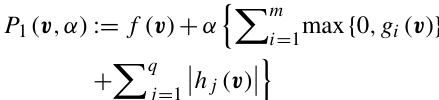
Algorithm 2 (customized active-set method for